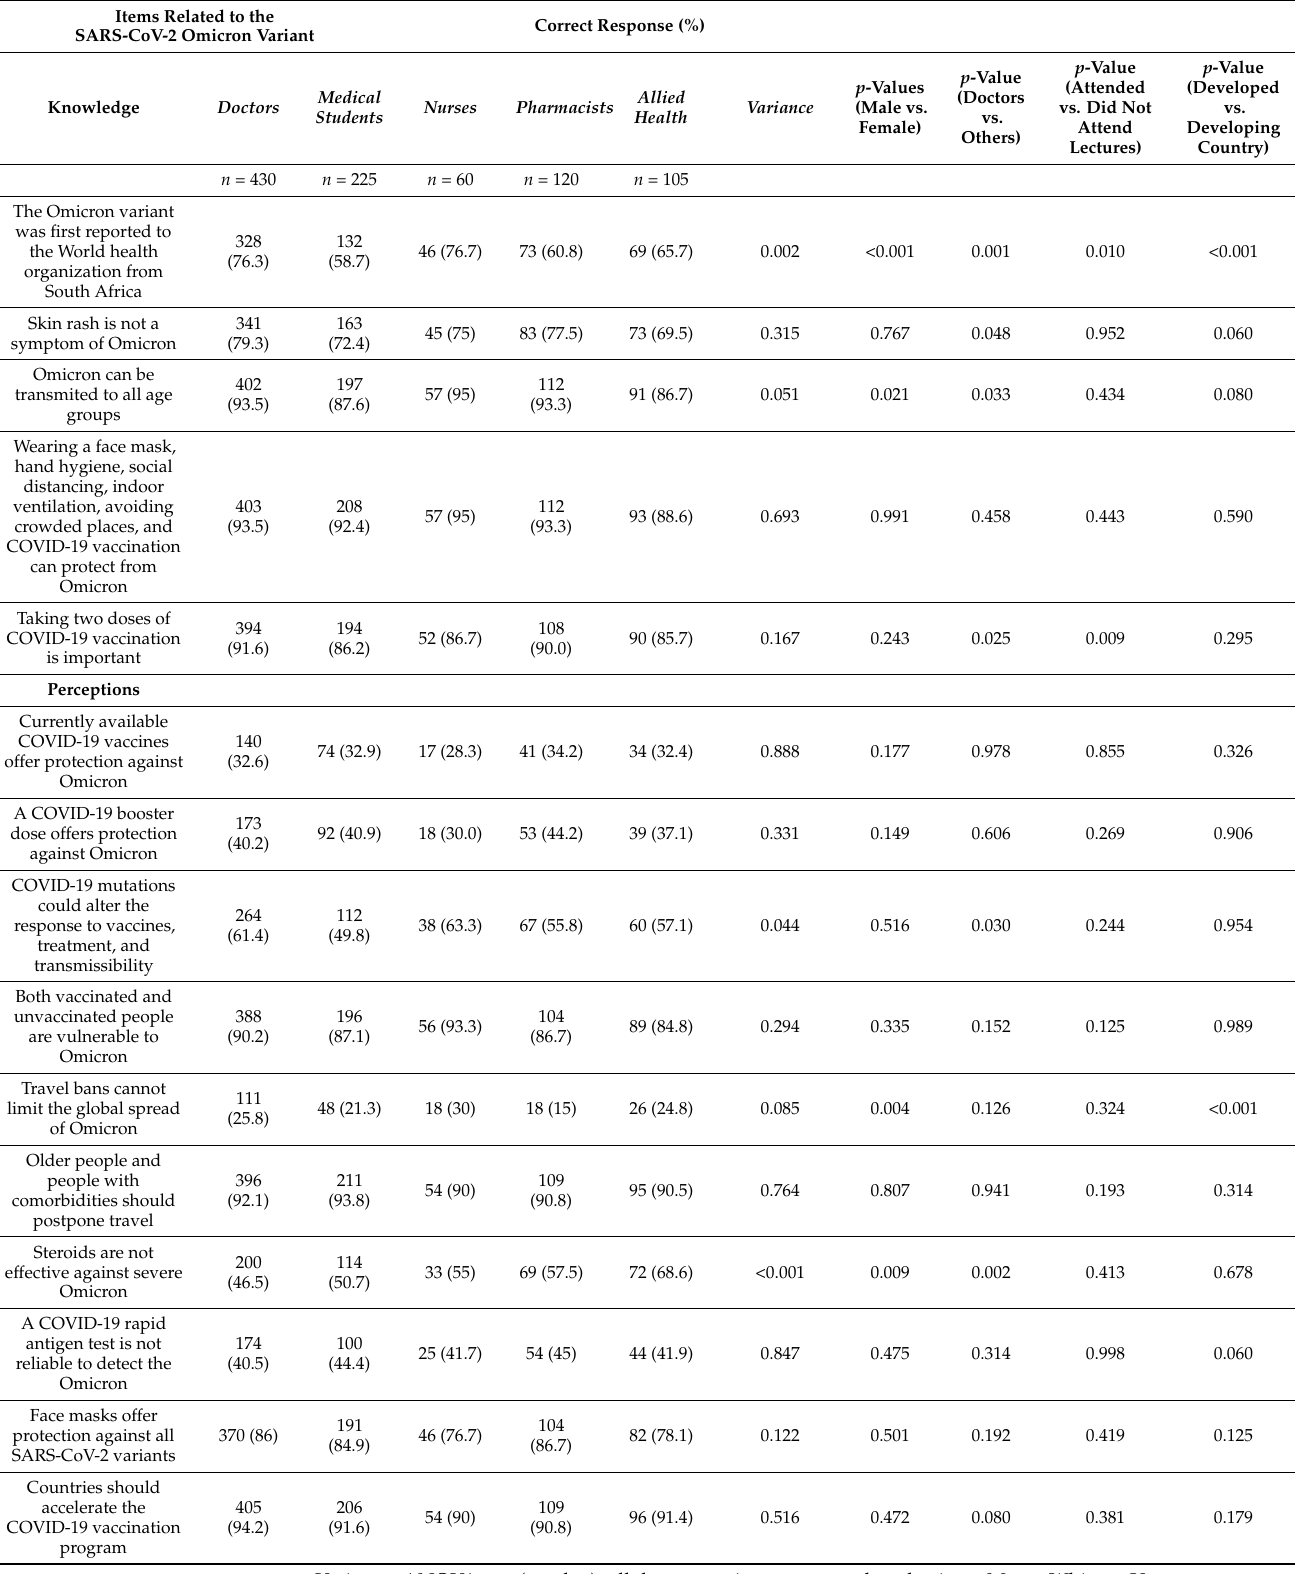
Table 2. Healthcare professionals’ knowledge and Perceptions about the SARS-CoV-2